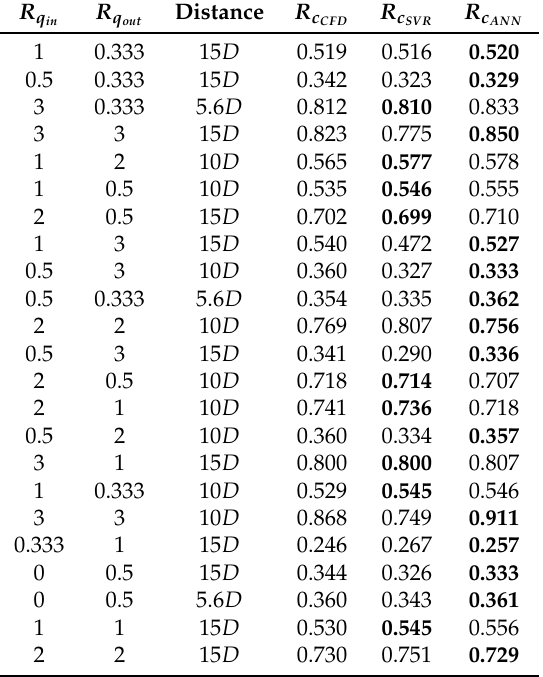
Table 10. Comparison of the testing data (30% of the whole generated data) predictions for SVR and ANN with bold values representing a better prediction.